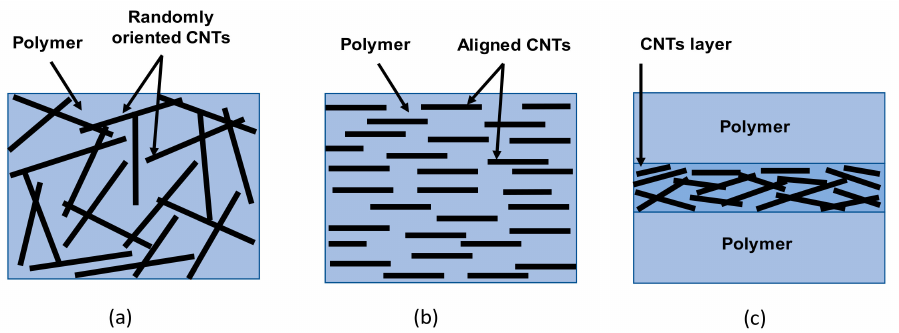
Figure 5. Different polymer/CNTs architectures: ( a ) randomly oriented polymer/CNTs nanocom- posite, ( b ) aligned CNTs in polymer matrix and ( c ) sandwiched CNTs layers between two layers of polymer.